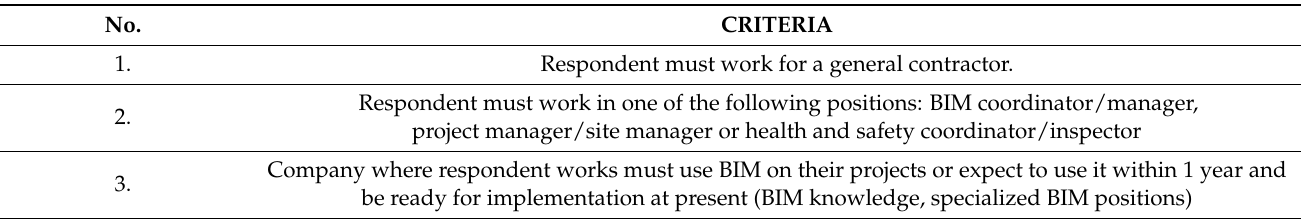
Table 1. Criteria for selection of respondents for questionnaire and interviews.